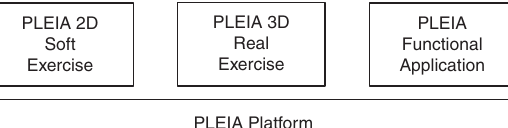
Fig. 3. PLEIA functional